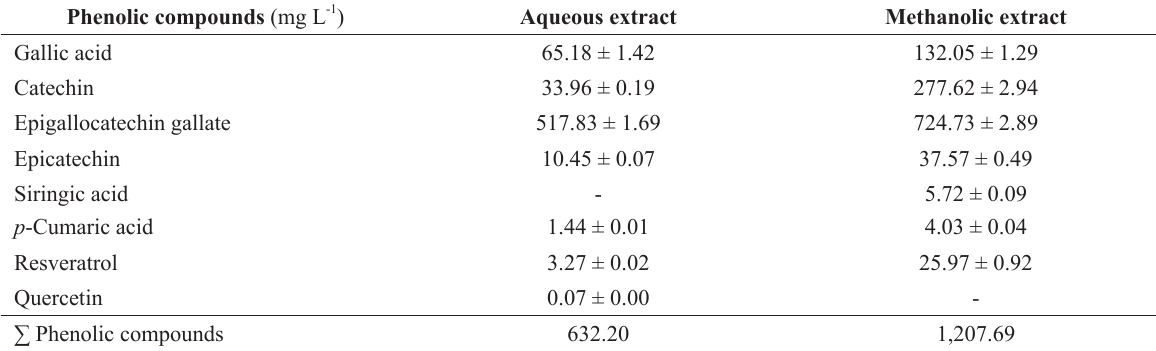
Phenolic compounds content in aqueous and methanol extract of jabuticaba skin